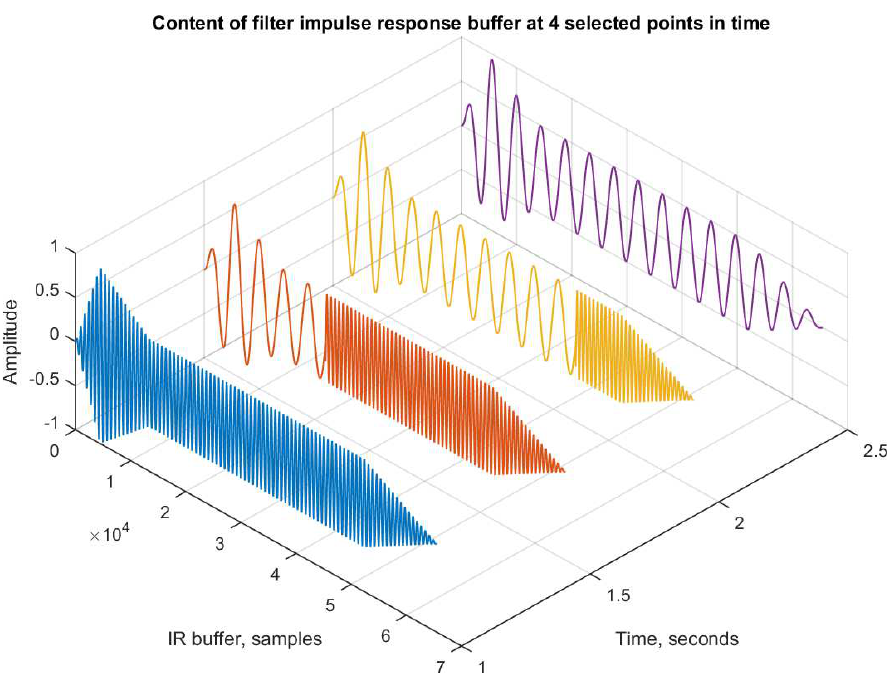
Figure 4. Demonstration of dynamic filter replacement: The content of the filter impulse response buffer at four different points in time: Before transition (1.0 s), 1/3 into the transition (1.5 s), 2/3 into the transition (2.0 s) and after the transition (2.5 s). These time indices are marked with vertical lines in Figure